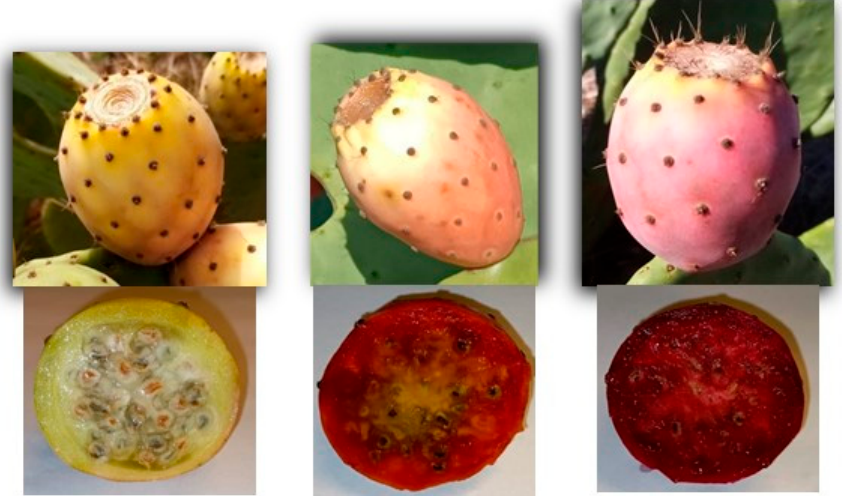
Figure 2. White, orange, and red prickly pear ecotypes and image of the respective cross-sections of the fruits.